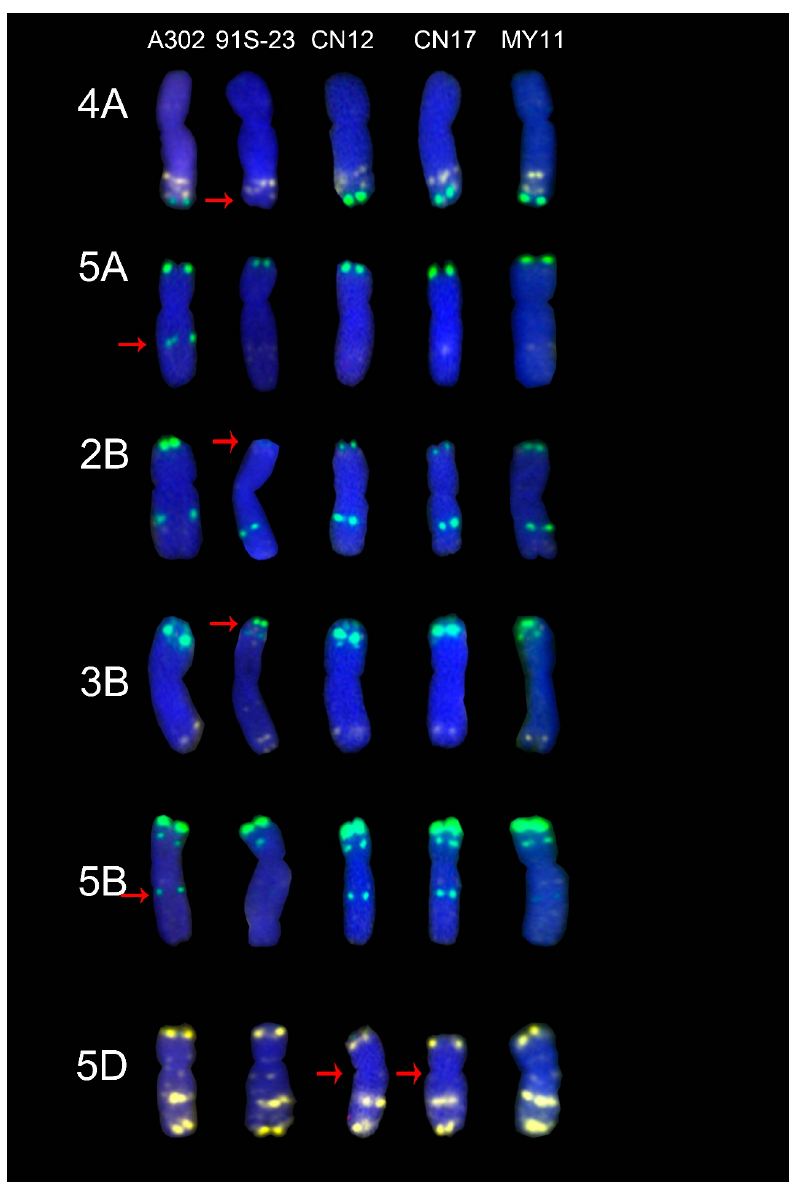
Figure 4. The differences of ND-FISH signal patterns in CN12 and CN17 cultivars when they were compared with their parents. From left to right: A302, 91S-23, CN12, CN17 and MY11, respectively. The red arrows showed the mutant signal patterns on chromosomes. Yellow: Oligo-pTa535-1; Green: Oligo-pSc119.2-1; Red: Oligo-Ku, Oligo-pSc200 and Oligo-pSc250. Blue: DAPI.